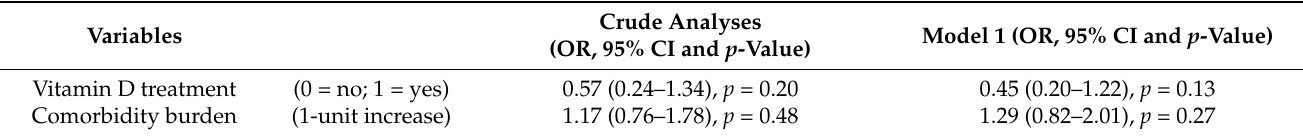
Table 3. Crude and adjusted logistic regression analyses to examine the association between vitamin D and study